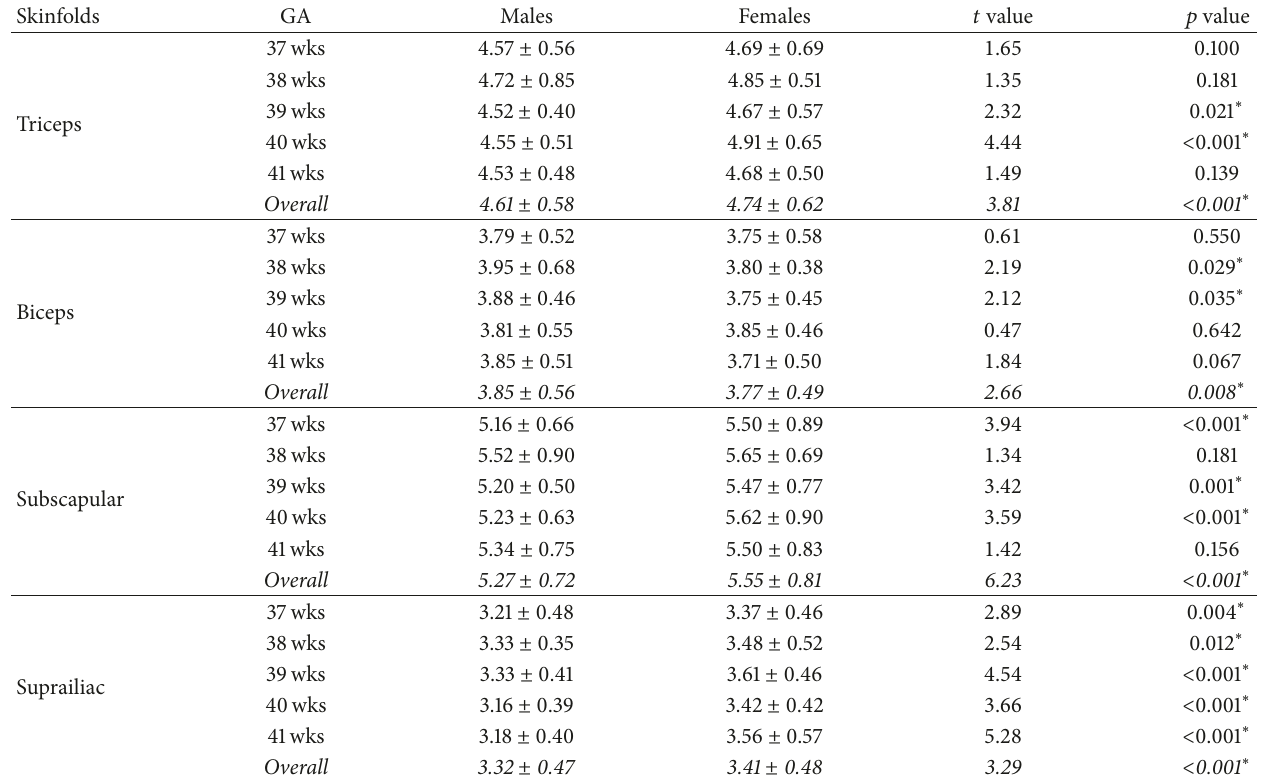
Table 2: Skinfold thickness mean ± SD (mm) by gestational age and gender.